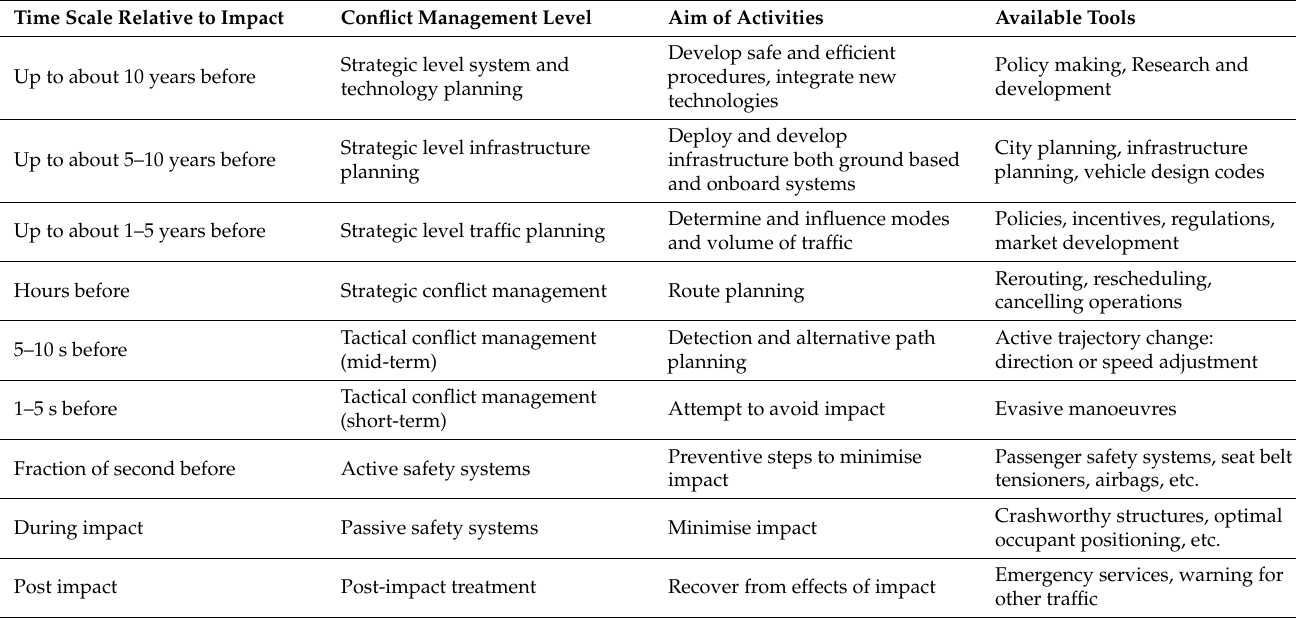
Table 2. Generalised conflict management